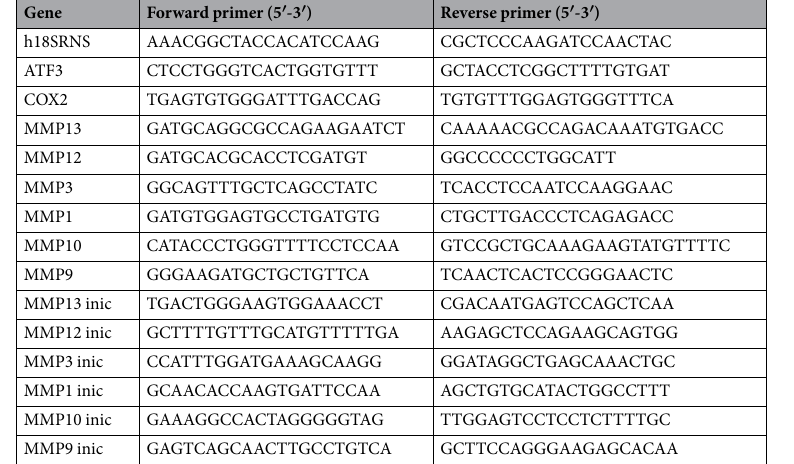
Table 1. Sequences of primers used for qPCR